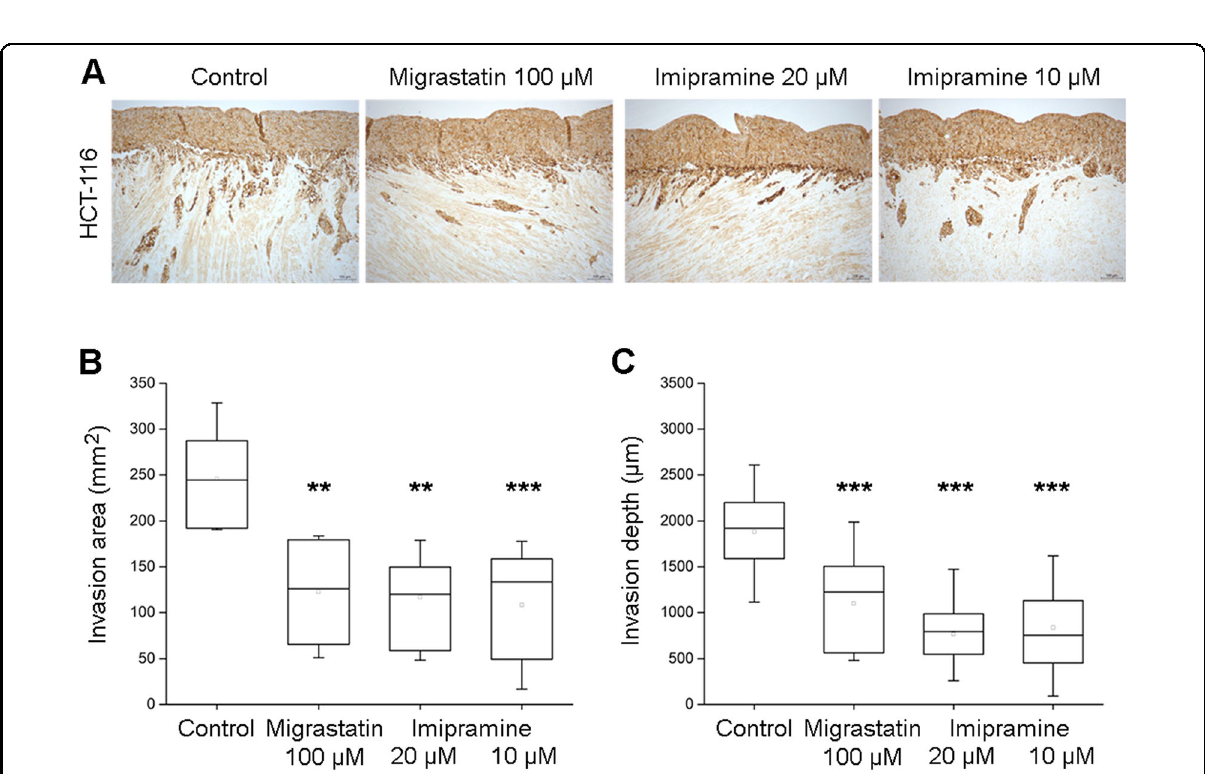
Fig. 6 Myoma organotypic invasion model showing. a The effect of 100 µM migrastatin and imipramine (10 and 20 µM) on the HCT-116 colorectal cell line. Quanti fi able effect on the invasion area ( b ) and on the invasion depth ( c ). ** p < 0.001, *** p <